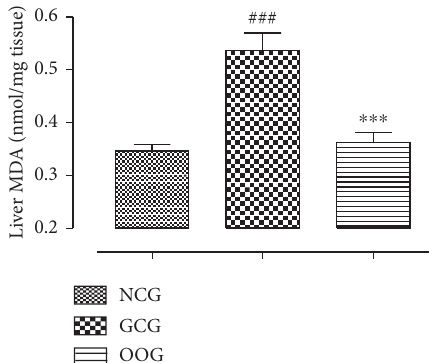
Figure 4: The amount of MDA produced in the kidney for all treated group animals. ∗ P < 0 . 001, compared to the GCG. ## P < 0 . 001, compared to the NCG.